Question: Name the type of graph shown.
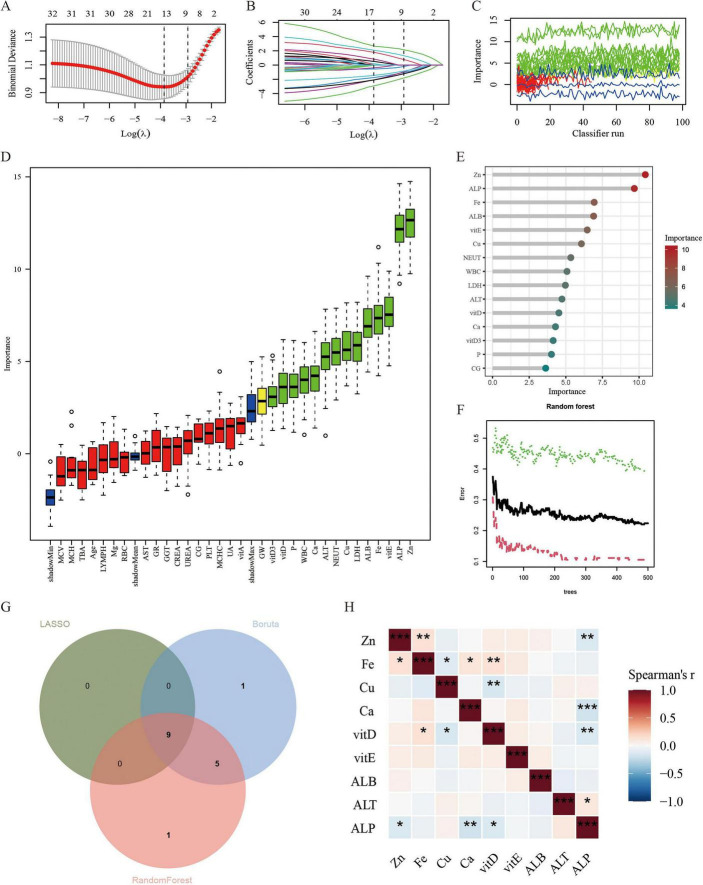
Answer: heatmap